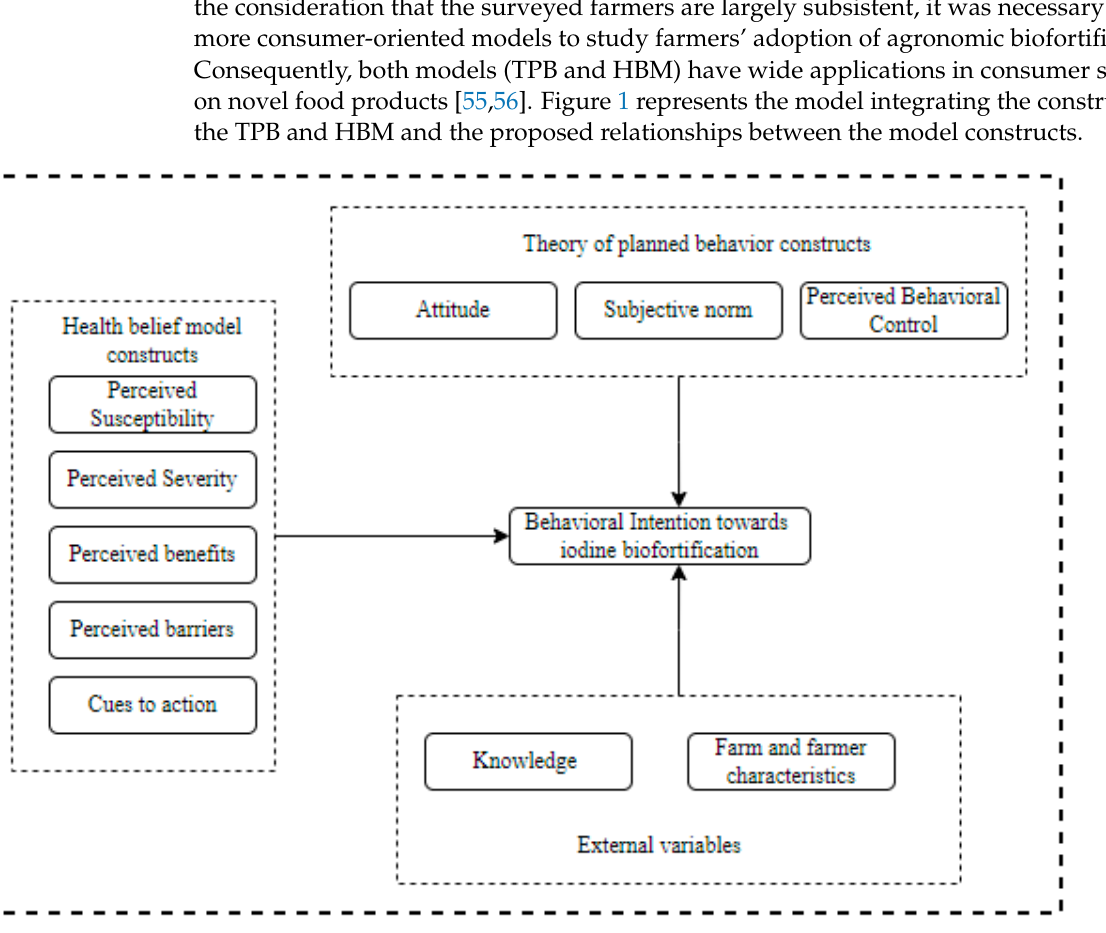
Figure 1. An integrated Theory of Planned Behavior and Health Belief Model for the prediction of farmers’ behavioral intention towards agronomic iodine bioforti fi cation (own compilation based on farmers’ behavioral intention towards agronomic iodine biofortification (own compilation based [37,39,43,45] ). on